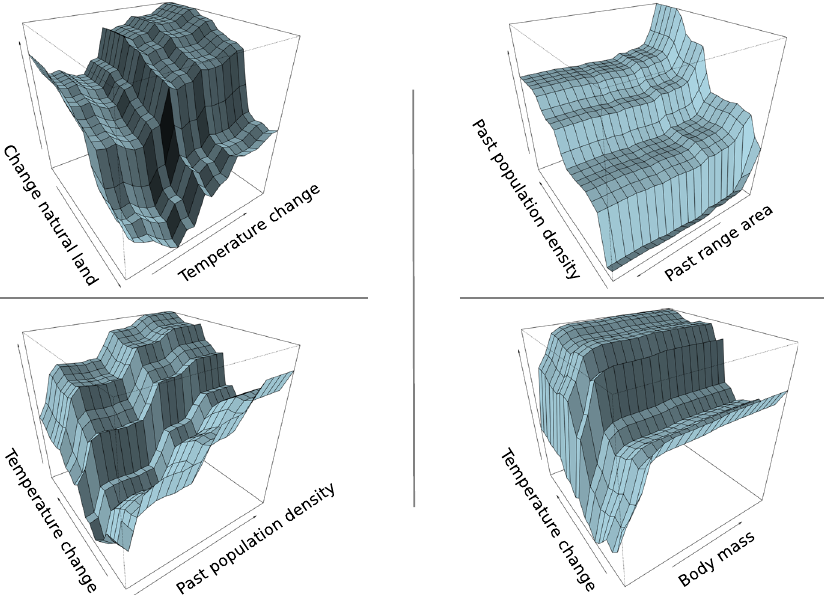
Fig. 3 Partial dependence plots to show the effects of selected pairs of predictors on range contraction. Top-left plot shows the negative interaction of change in natural lands with mean annual temperature; the top-right plot represents the negative interaction of human population density in the past with the size of the past range on range contraction; the bottom-left plot describes the positive interaction of change in mean annual temperature with past human population density; the bottom-right plot illustrates the positive interaction of body mass with mean annual temperature change on range contraction.